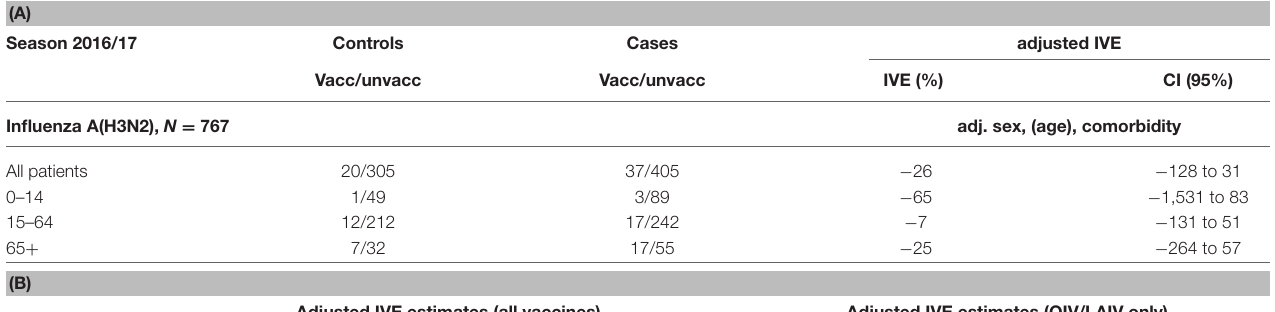
TABLE 2 | Number of cases and controls (vaccinated and unvaccinated) and influenza vaccine effectiveness (IVE) adjusted for sex, age, and comorbidity for the seasons 2016/17 ( A ), 2017/18 ( B , including additionally also IVE estimates for QIV) and 2018/19 ( C ); n.d., not done; QIV, quadrivalent inactivated influenza vaccines; CI, confidence